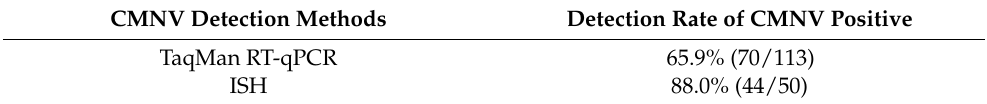
Table 2. Detection of CMNV of M. rosenbergii samples collected from shrimp ponds in Gaoyou.